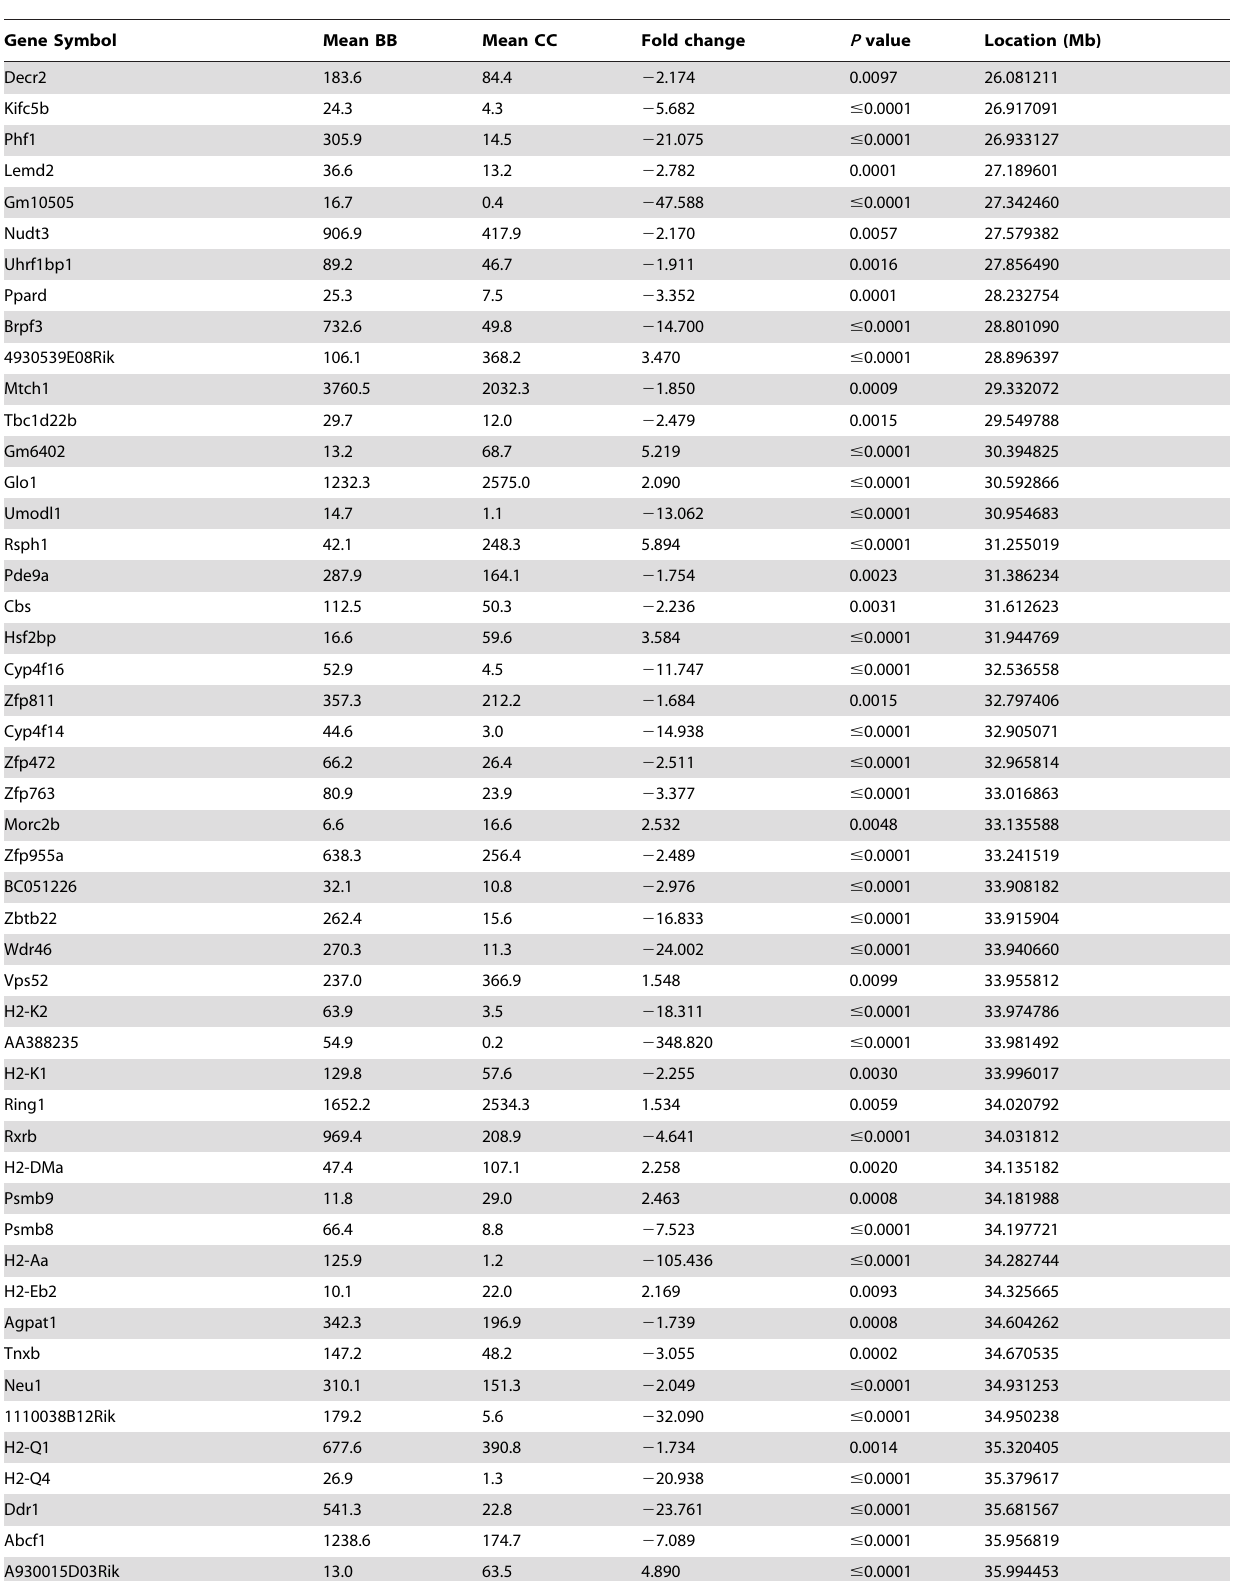
Table 3. Differentially expressed genes in the hypothalamus of homozygous cast/cast vs. b6/b6 subcongenic-derived F 2 mice, located within the fine mapped QTL interval of 26.08–45.12